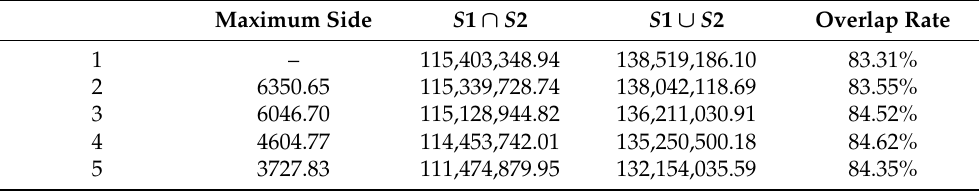
Table 4. Eliminate the largest edge of the outer contour of the triangle